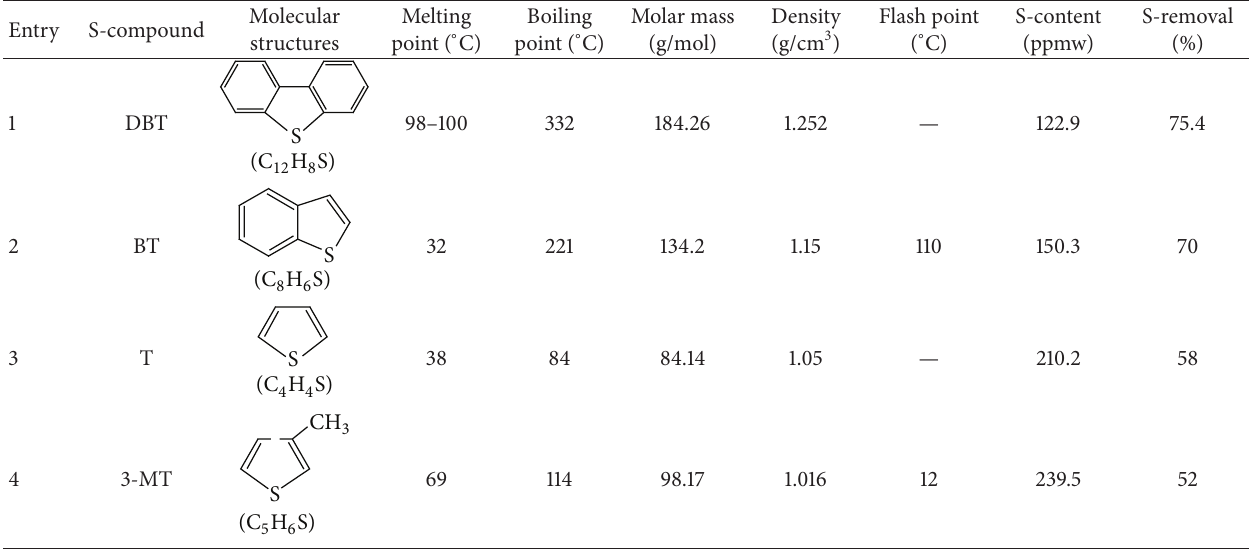
Table 1: Effect of sulfur compounds on extraction with [BMIM]Cl.